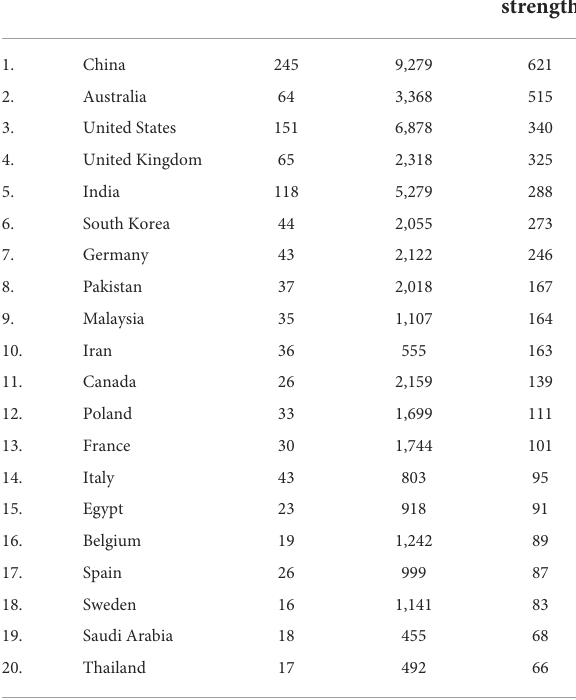
TABLE 1 Top 20 countries based on total link strength using bibliographic analysis approaches.